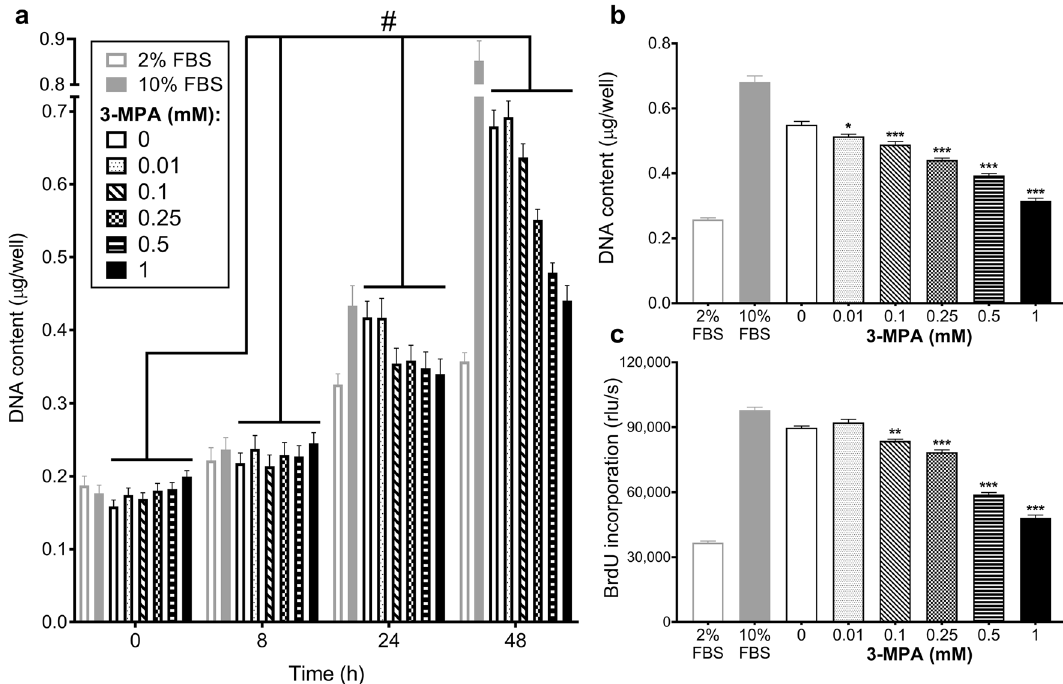
Figure 1. Treatment with 3-MPA reduced C2C12 cell number by inhibiting proliferation. Proliferating C2C12 cells were treated with a range of 3-MPA doses (0.01–1 mM) or equivalent volume of vehicle control (PBS; 0 mM 3-MPA) diluted in GM supplemented with 5% (v/v) FBS. ( a ) Cells were collected for total DNA quantification after 0, 8, 24 and 48 h of treatment. Data presented as Means (n = 16) ± SEM. Two-way ANOVA was performed: # P < 0.001 (time × treatment interaction). Cells were also either ( b ) collected to quantify total DNA content after 48 h or ( c ) incubated with BrdU labelling solution for the final 3 h of the 48 h period to quantify BrdU incorporation. The data presented in ( a ) and ( b ) were obtained in separate experiments. Data presented as Means (n = 8) ± SEM. One-way ANOVA was performed, followed by a Dunnett’s multiple comparison to vehicle control (0 mM 3-MPA): * P < 0.05, ** P < 0.01 and *** P < 0.001. 2% and 10% (v/v) FBS were internal controls and therefore excluded from the statistical